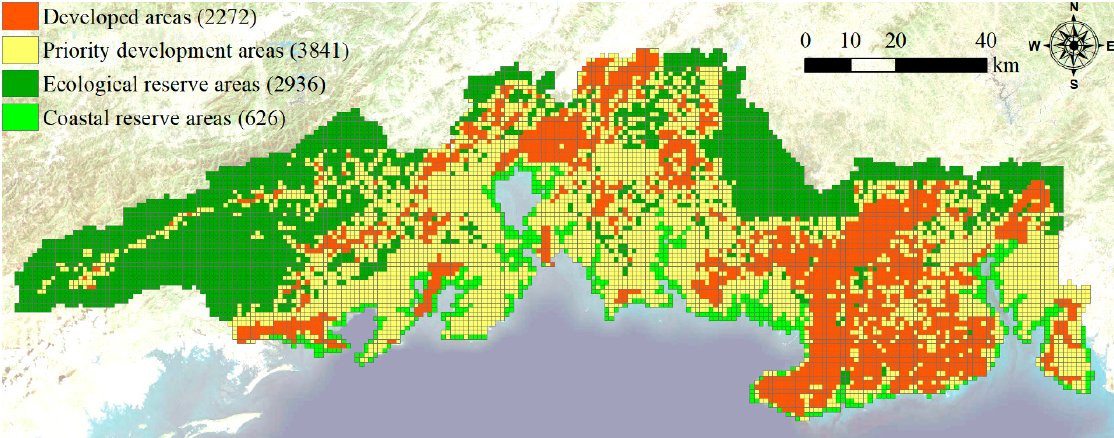
Figure 6. Zoning layout based on comprehensive carrying capacity.